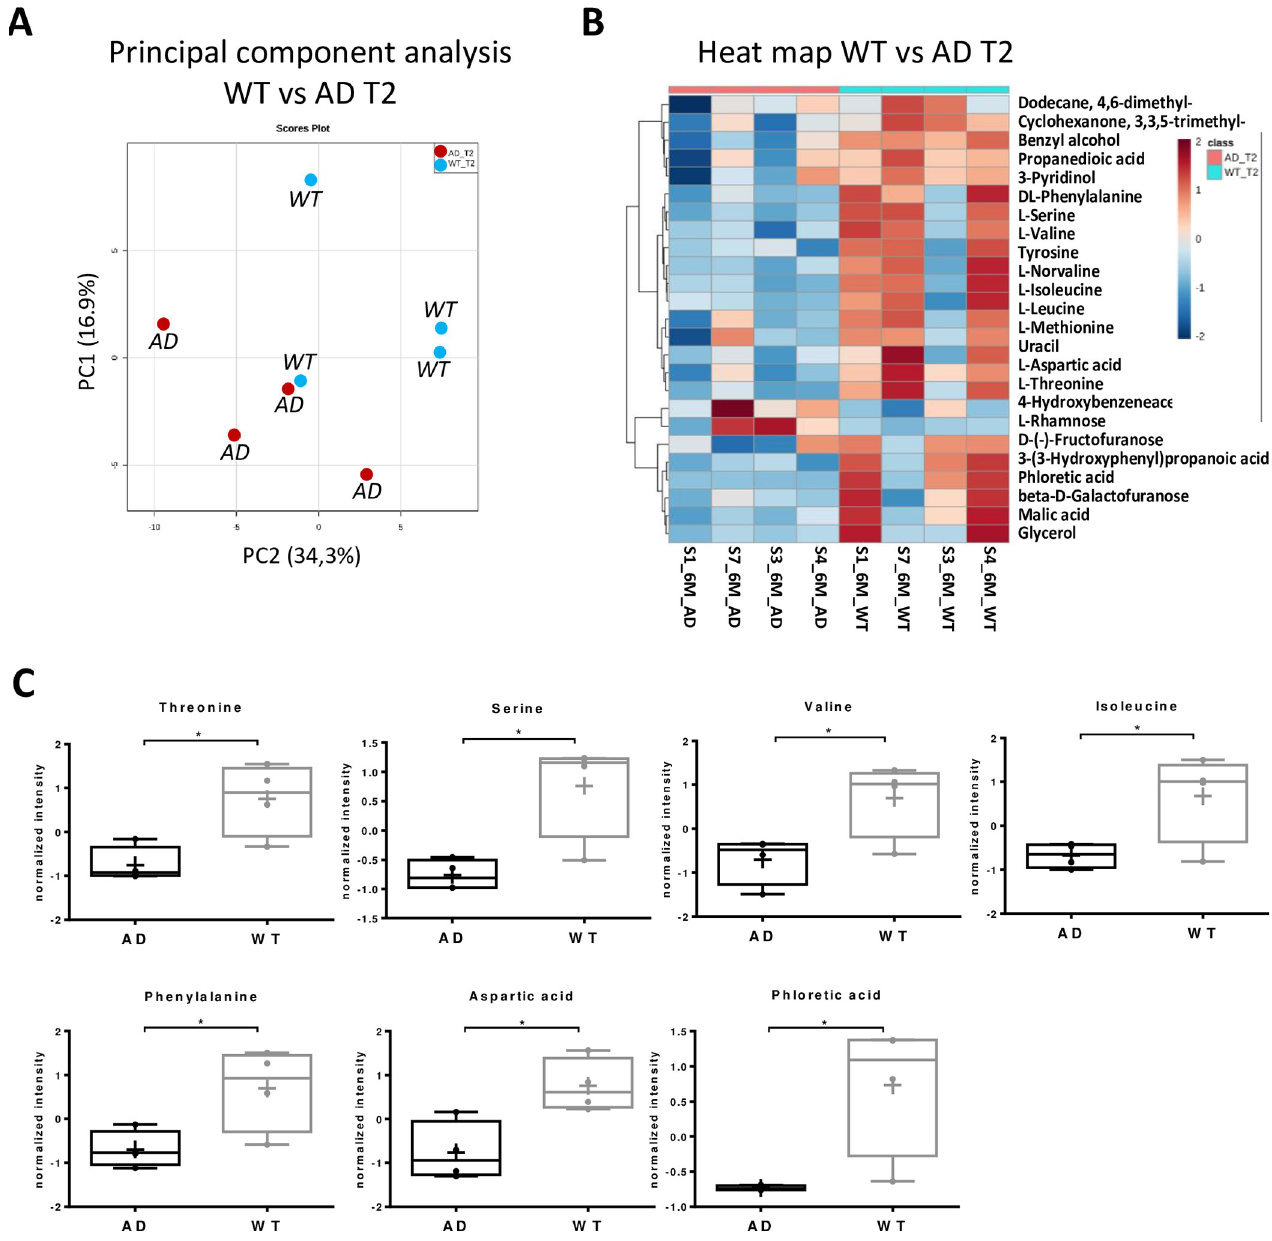
Fig 5. Metabolic profile of small molecules from aqueous phase extraction of AD mouse fecal samples, at six months. A) Score plot of principal component analysis (PCA) showing two distinct groups, the WT (light blue) and the AD mouse model (red). B) Hierarchical clustering heat-map of the most modulated metabolites. C) Box plot of modulated amino acids and phloretic acid at six months (T2), expressed as ‘normalized intensity’, corresponding to normalized abundance of the molecules reported in the heatmap (panel B). � p < 0.05; �� p < 0.01; ��� p < 0.0005. and a genus from Firmicutes phylum (Roseburia) showed significant negative correlations with the classes of amino acids and phenylpropanoic acid under-represented in AD at T2, while significant positive correlations were reported with benzene and substituted derivatives, fatty acyls and carboxylic acids (Fig 6B). In the individual metabolite correlation heat map (Fig 6C) the above-mentioned genera showed positive correlations with four metabolites (red) and negative correlations with eight molecules (blue).